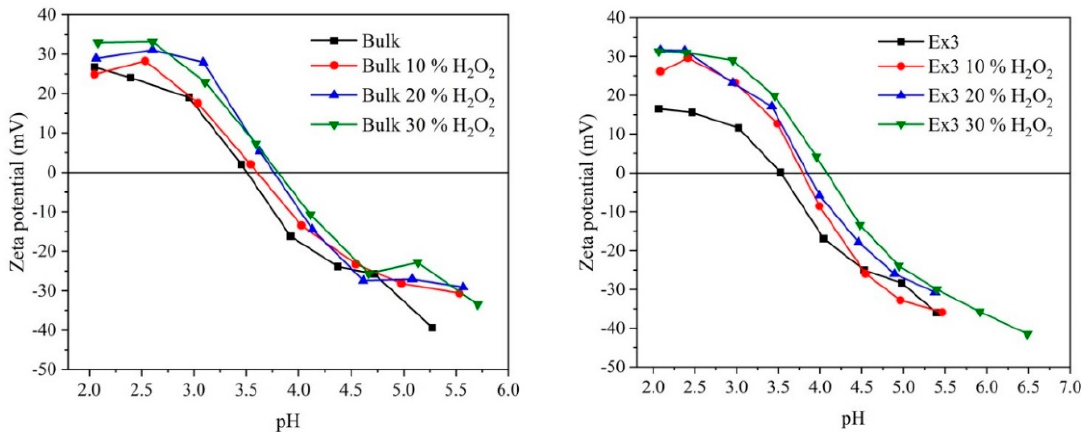
Figure 14. Zeta potentials of bulk ( left ) and selected exfoliated GCN nanomaterials ( right ) depending on pH.